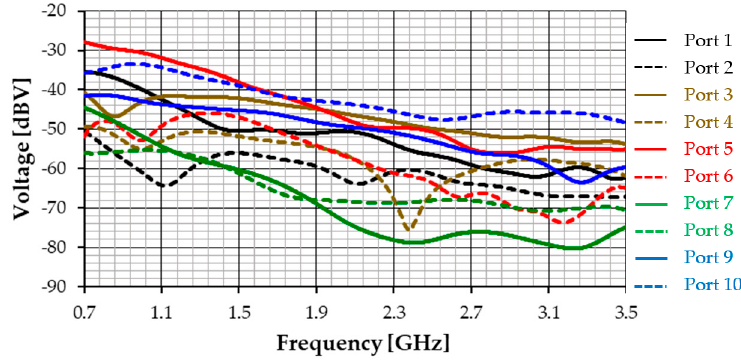
Figure 25. Voltage induced at each port for the example of incidence shown in Figure 24.